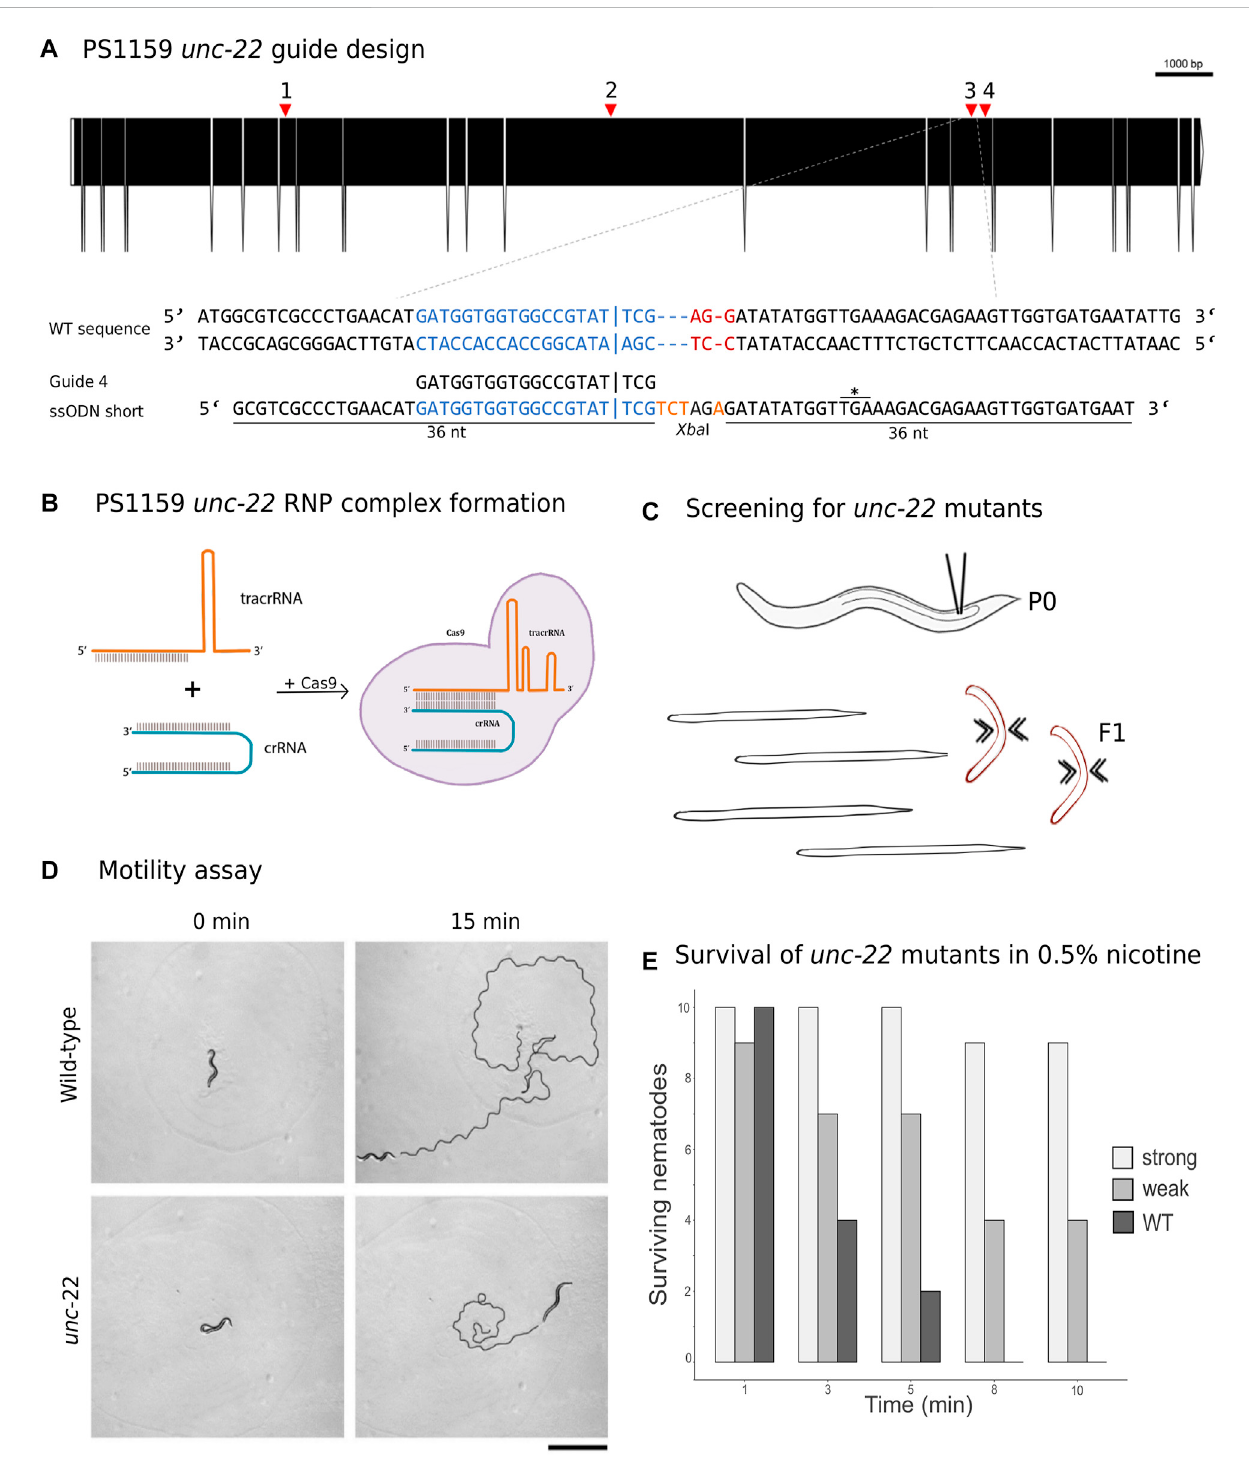
FIGURE 2 (A) CRISPR target site for Panagrolaimus sp. PS1159 unc-22 . Predicted gene structure. Black boxes = exons. Red arrows = CRISPR target regions. Zoom into part of exon 15 coding strand with target region (blue) and PAM site (red). Vertical bar indicates the expected Cas9 cleavage site. Example of guide sequence andsingle-stranded oligodeoxynucleotide(ssODN)homologyarms (36 nt) fl ankingthecleavage siteonbothsides andinsertionofa Xba I cleavage site (orange). Asterisk shows in frame stop codon after successful incorporation of desired bases. Gene fi gure was designed by using the Exon-Intron Graphic Maker (version 4, http://wormweb.org/exonintron). (B) Ribonucleoprotein complex assembly. Cas9 protein, crRNA and tracrRNA are mixed and incubated. (C) RNP complexes are introduced into the syncytial part of the gonad of an adult worm (P0) by microinjection. Screen for twitching phenotype in F1 generation. (D) Motility assay: Observation of motility of wild-type worms vs strong twitching F1 in the time course of 15 min ( n = 10); black line shows movement; scale bar = 1 mm. (E) Survival assay: Wild type worms and F1 progeny after injection with a phenotype (strong and weak) are screened in 0.5% nicotine for a total of 10 min for survival ( n = 10 for